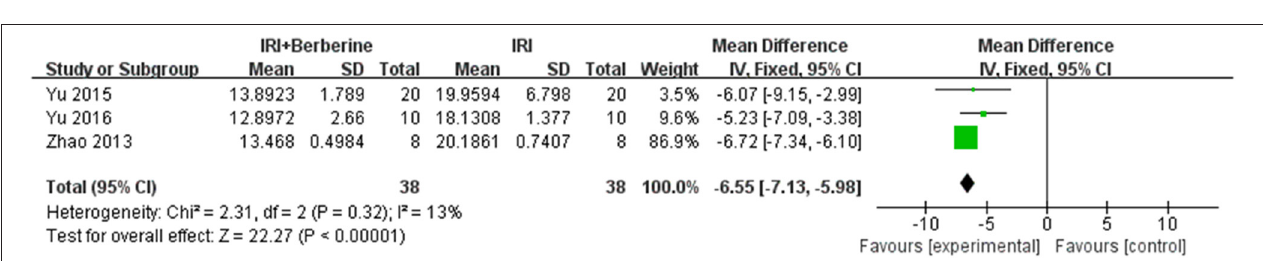
FIGURE 12 | Forest plot showing the effects of BBR on decreasing CK compared to the control